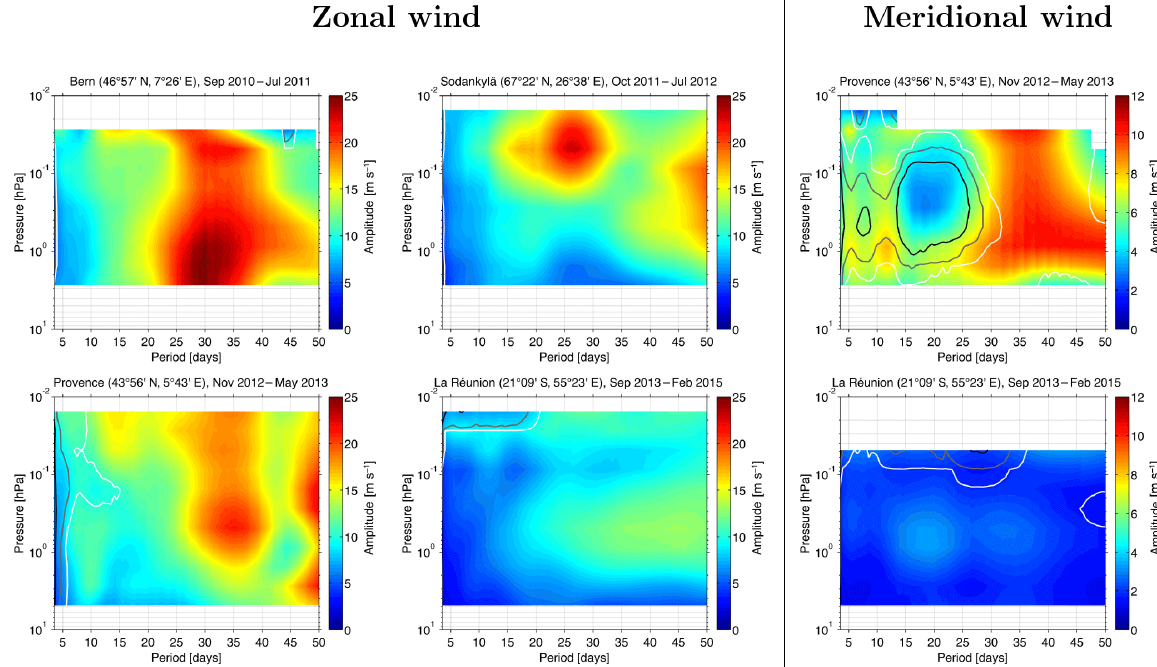
Figure 3. As Fig. 2 but for the scenario ECMWF at WIRA, i.e., for ECMWF profiles convolved with WIRA’s averaging kernels and with data gaps introduced where WIRA did not provide reliable measurements.